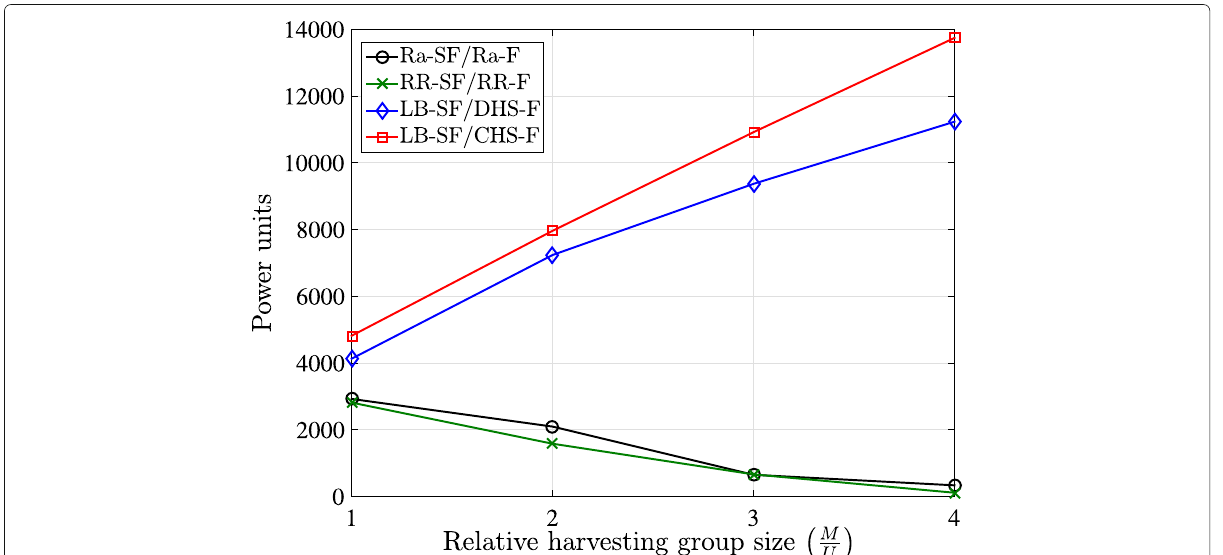
Fig. 11 Sum of expected harvested powers by all users vs relative size of the harvesting user group. Sum of the expected harvested powers by all users (in power units) as a function of the relative size of the harvesting user group the optimum value of the objective function. Additionally, as more users are able to recharge their batteries (see Fig. 11), they can decode higher rates in future